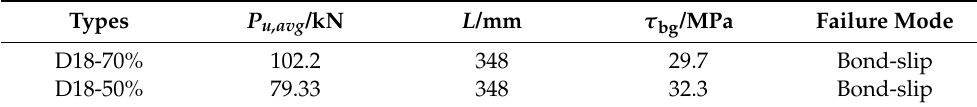
Table 5. Theoretical strength of the rebar-grout bond